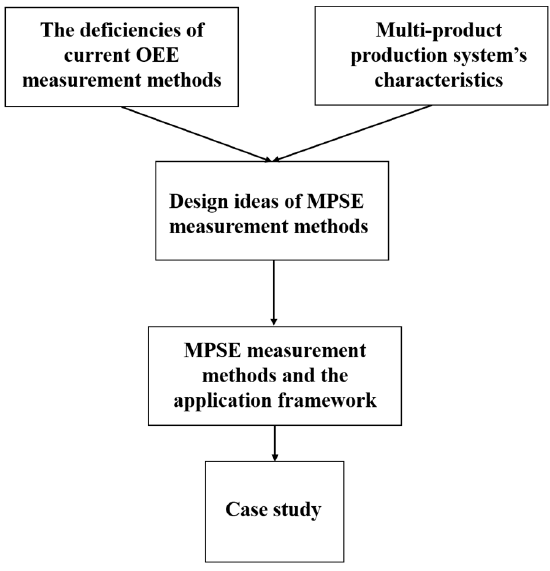
Figure 1. The research scheme.